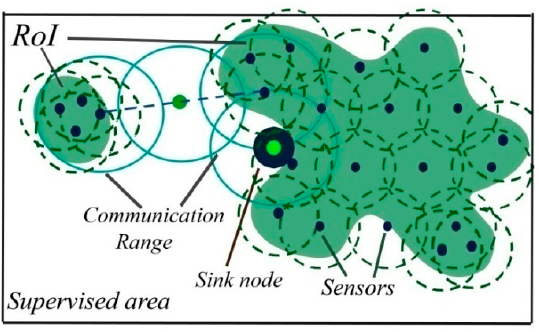
Figure 11. Topology ensuring maximum interest, full coverage, and connectivity.